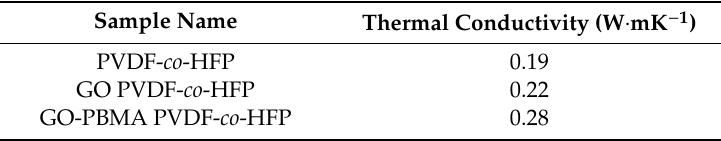
Table 2. Thermal conductivity of various non-woven fiber mats.